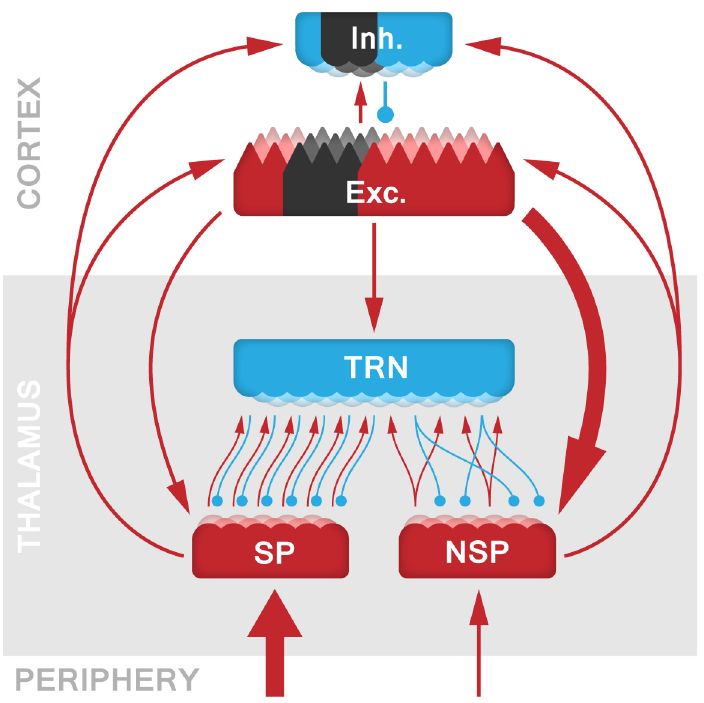
Fig 3. Schematic representation of the TCS model architecture. The thalamic component of the model comprises specific (SP; corresponding to the ventral posterior complex of the thalamus in the somato- sensory domain), non-specific (NSP; comparable to the intralaminar nuclei) and the thalamic reticular nucleus (TRN). The cortical layer includes both excitatory (Exc.) pyramidal cells and inhibitory (Inh.) interneurons. Excitatory connections are marked with red lines terminating in arrowheads, while inhibitory connections are blue with circles indicating their synaptic terminals. The simulated stroke is implemented by removing the cortico-cortical connections from a specific cortical area, marked in black. All the model ’ s parameter values can be found in Tables 1 – 3.